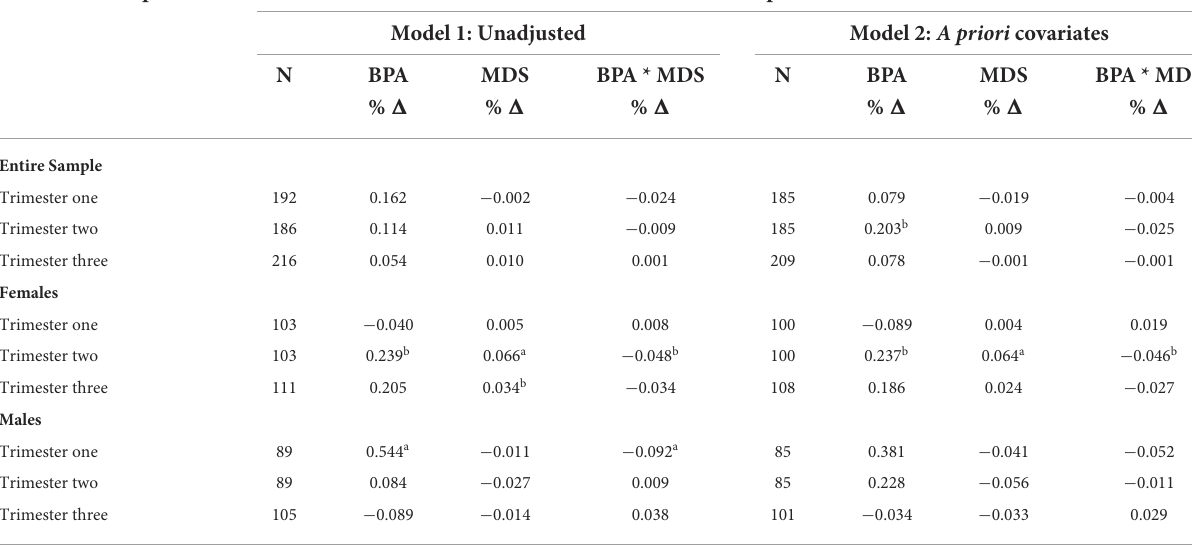
TABLE 5 Percent change in adolescent 8-isoprostane per 1-unit increase in urinary ln-transformed prenatal maternal urinary BPA. Trimester of